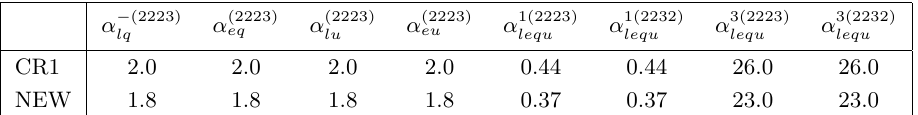
Table 1 . Coe(cid:14)cients of the master equation (2.14), in TeV 4 , for the di(cid:11)erent signal regions and for LHC13. In the HL-LHC, the coe(cid:14)cients should be multiplied by a factor 100 to account for the increase in production cross section and luminosity. See text for the de(cid:12)nition of the di(cid:11)erent signal